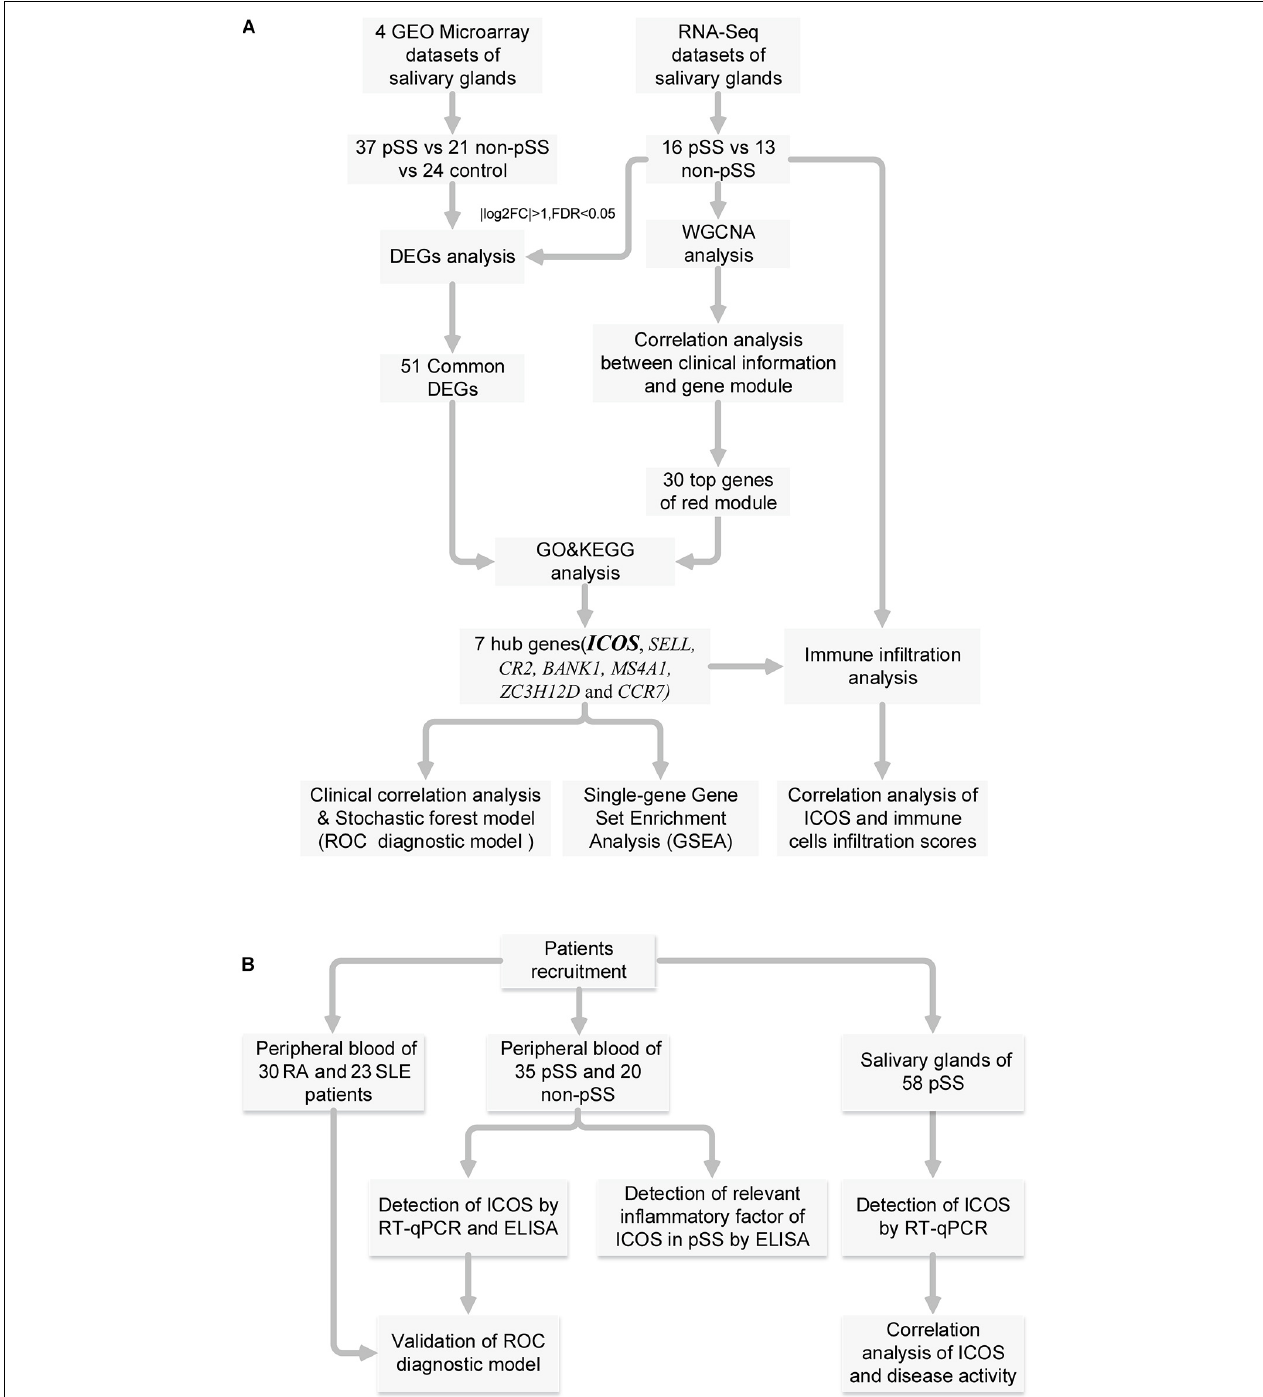
FIGURE 1 | Summary and description of the study workflow. (A) The workflow of identification of hub genes, correlation analysis and construction of diagnostic model. (B) The workflow of special assessment of models and experimental validation for pSS.